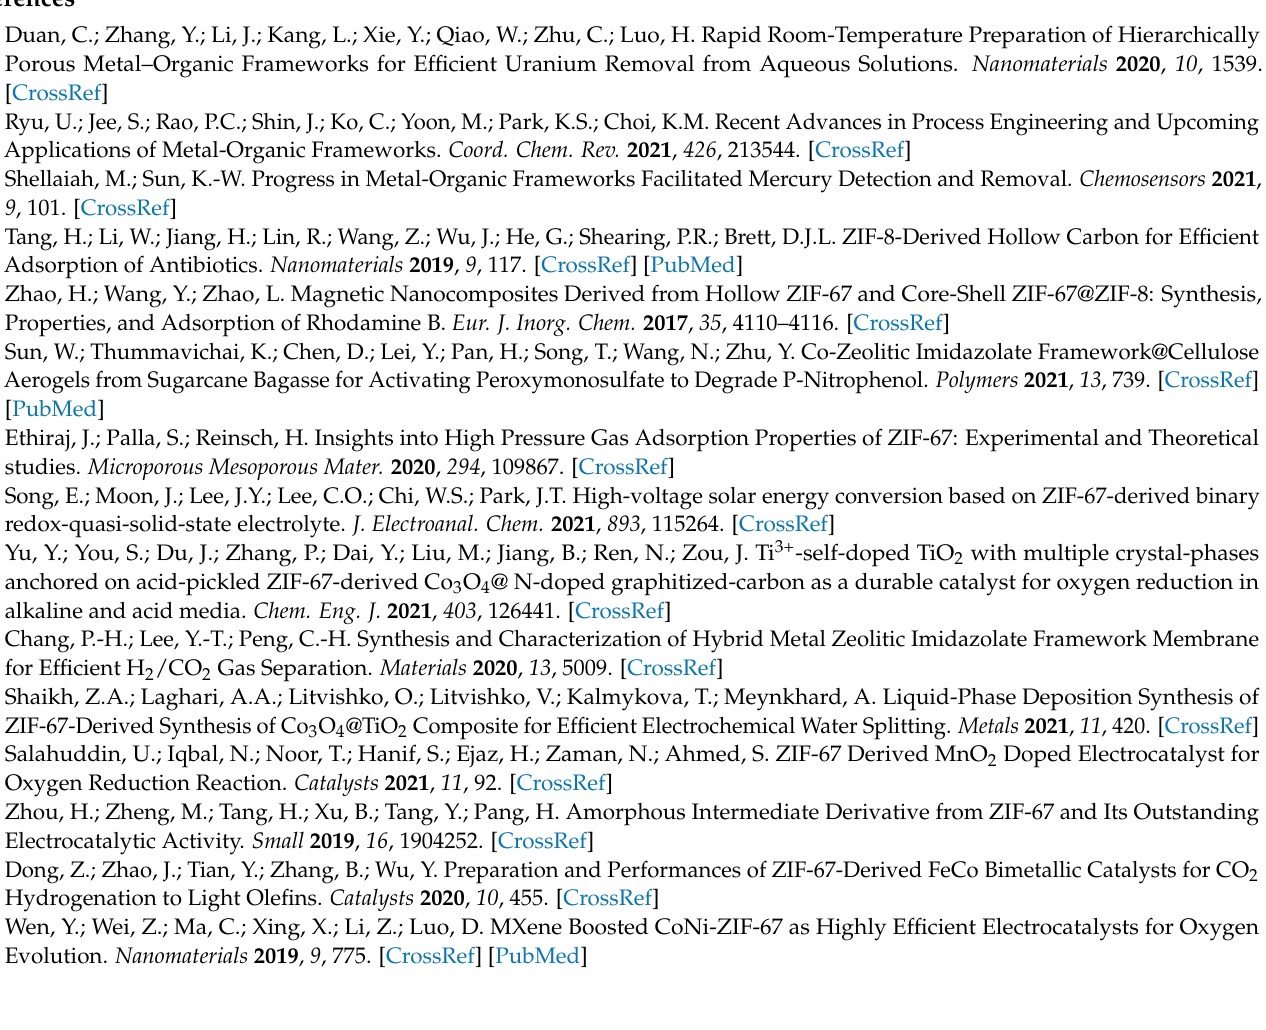
Figure S3: Electrocatalytic CO 2 reduction selectivities, Figure S4: Electrochemical CO 2 reduction product